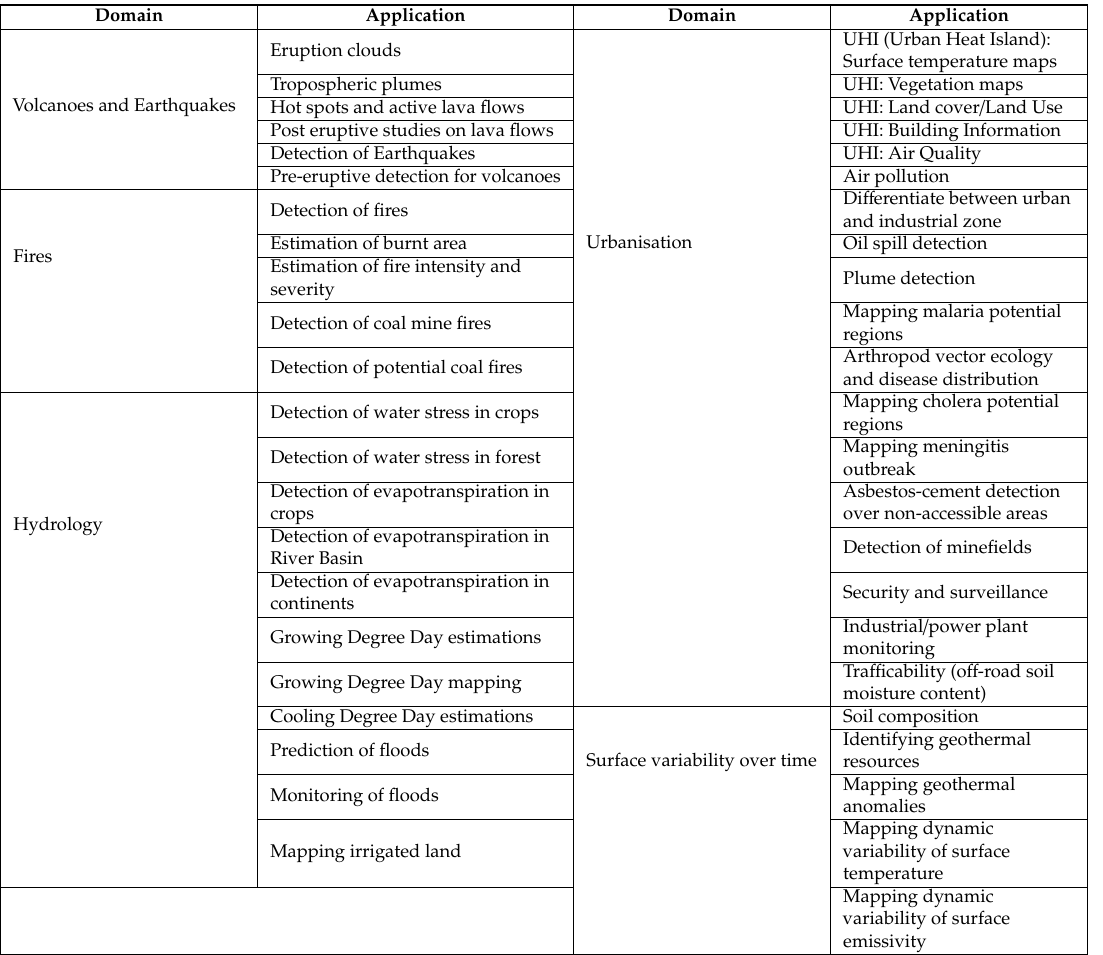
Table 1. Applications of high resolution, hyper-spectral thermal infrared instruments